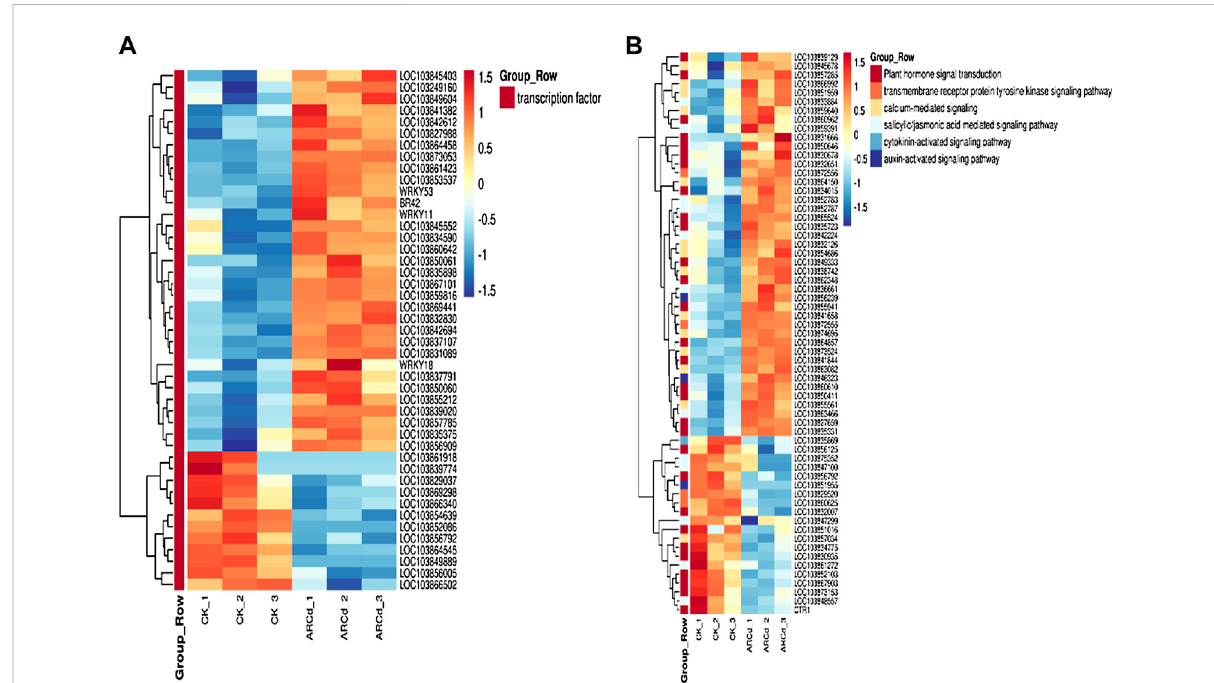
FIGURE 8 (A) Heat maps represented the log2-fold change in the expression of DEGs (red is upregulated and blue is downregulated) related to transcriptionfactorsbetweenthecontrolandAR-Cdtreatedgroups. (B) Heatmapsrepresentedthelog2-foldchangeintheexpressionofDEGs(red is upregulated and blue is downregulated) related to hormone signal transduction and calcium-mediated signaling between the control and AR-Cd treated